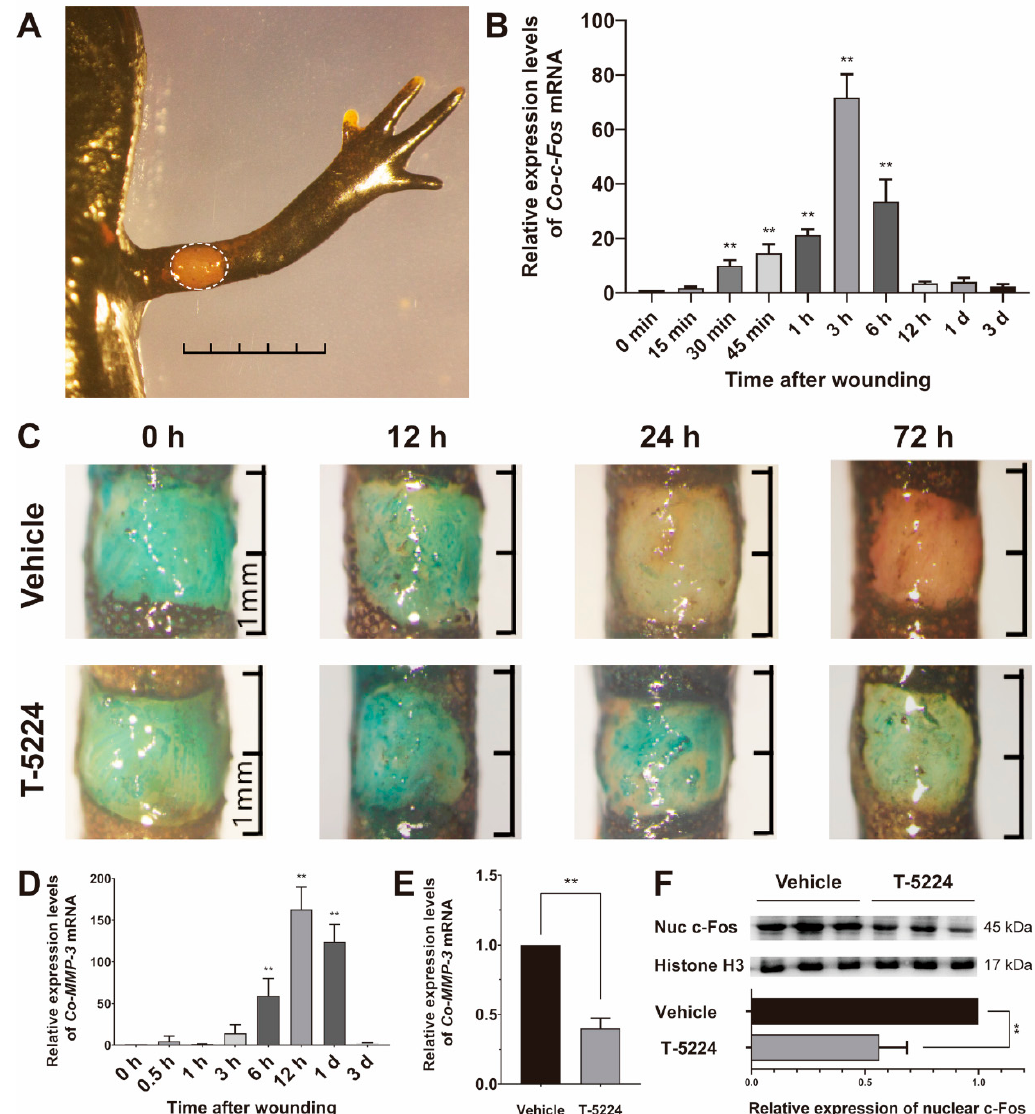
Figure 4. Role of Co-c-Fos in the process of the newt skin wound healing. ( A ) The newt skin wound healing model. The white outlines indicated the wound made in the limb of C. orientalis. Bar = 5 mm. ( B ) The mRNA expression pattern of Co-c-Fos mRNA during the newt skin wound healing. The mRNA expression level of Co-c-Fos at 0 min after wounding was set to one ( n = 3). ( C ) Inhibitory effect of T-5224 on the newt skin wound healing visualized by Fast Green staining at 0, 12, 24, and 72 h after wounding. ( D ) The mRNA expression pattern of Co-MMP-3 during the newt skin wound healing. The mRNA expression level of Co-MMP-3 at 0 min after wounding was set to one ( n = 3). ( E ) Inhibitory effect of T-5224 on the Co-MMP-3 induction at 12 h after wounding. ( F ) Inhibitory effect of T-5224 on the nuclear accumulation of Co-c-Fos protein. The abundance ratio to Histone H3 was analyzed by densitometry. Data were analyzed using one-way ANOVA with the least-significant difference test in ( B , D ) and Student t -test in ( E , F ). ** p < 0.05.